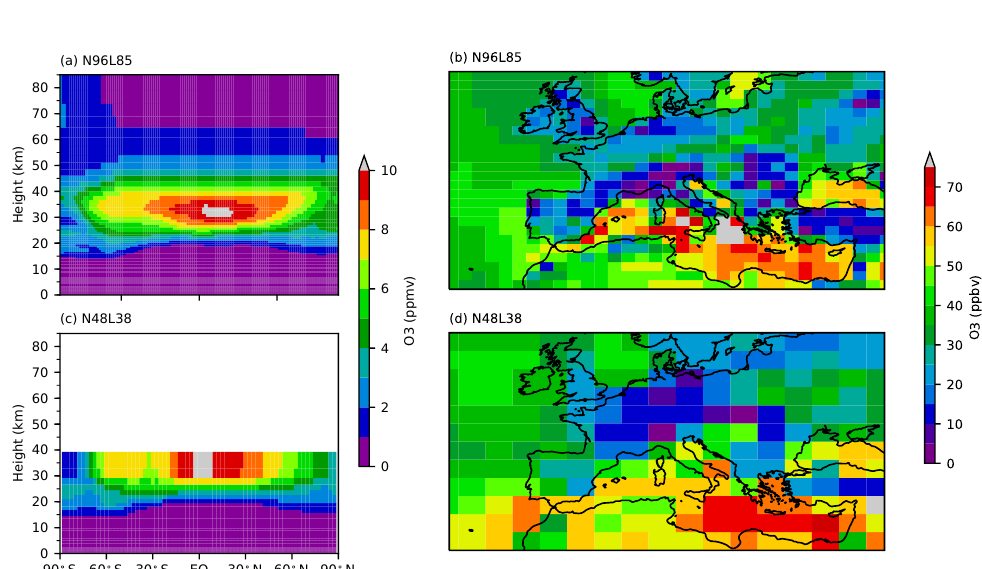
Figure 2. Comparison of modelled ozone from N96L85 and N48L38 UKCA configurations, highlighting the differences in model resolution and vertical extent. All plots are 3h means from the first 3 model hours of simulation: (a, b) N96L85 UM-UKCA configuration; (c, d) N48L38 UM-UKCA